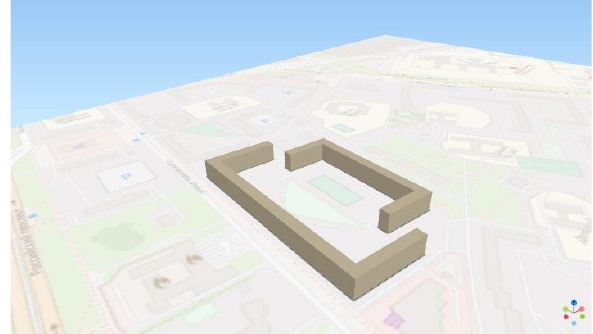
Figure 3 . 3D models of buildings No. 8/1 and 8/2 on Chudnovsky